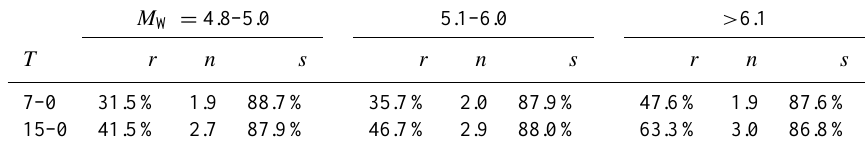
Table 4. The statistical results concerning seismic ionospheric influences on the ion density ( D = 0–1000km, d = 0–20km). M W =